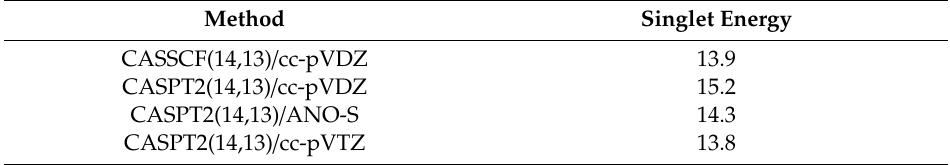
Figure 3. Optimized structures of azidoisoxazole 1 , nitrene 1 2 , nitrene 3 2 , and nitrosoalkene 3 using the B3LYP / 6-31 + G(d) level of theory. The numbers in parentheses are the energies in kcal / mol relative to the energy of conformer A of 1 . The calculated spin densities of nitrene 3 2 are displayed in red. Table 1. Computed singlet–triplet energy gaps (kcal / mol) for Nitrene 2